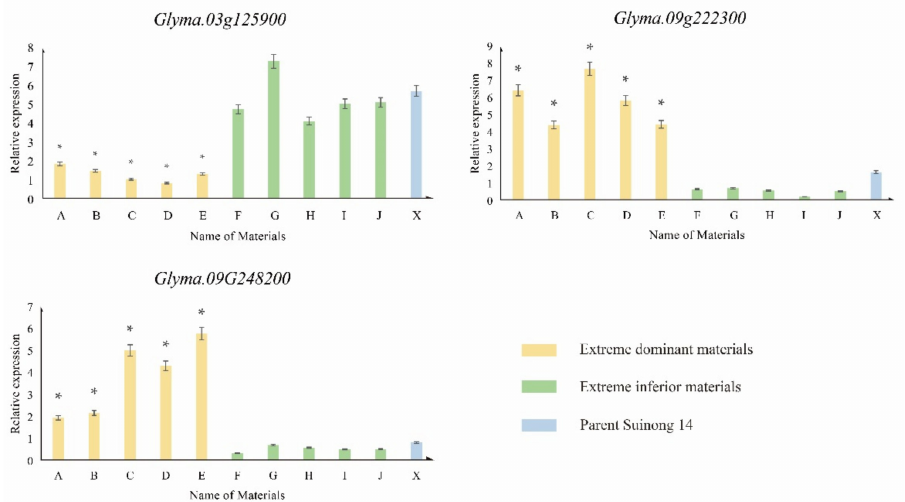
Figure 7. Relative expression of candidate genes by RT-qPCR. * denotes a significant di ff erence between the extreme material and others ( p <